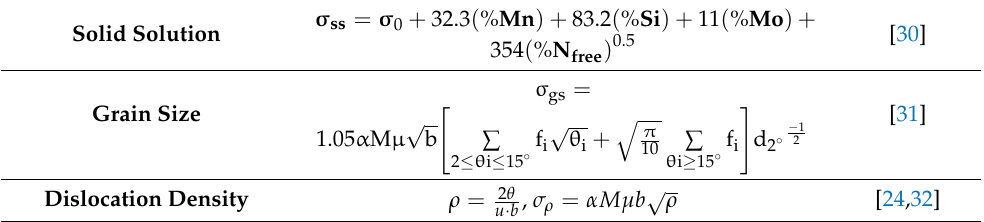
Table 4. Summary of the used equations for estimating the contribution of different strengthening